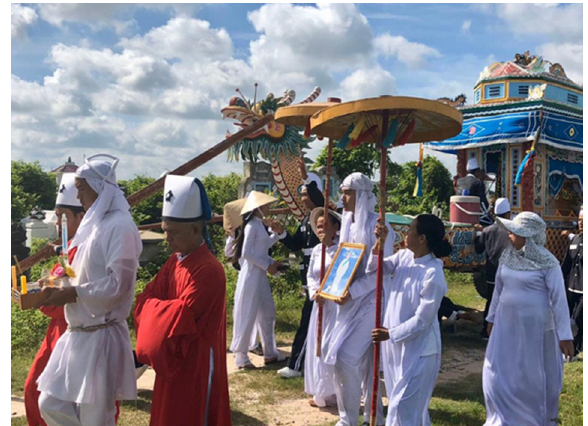
Figure 13. On the way to the cemetery, with the coffin placed in the Bát Nhã boat, behind the procession, Tây Ninh, 2 July 2018 (© Shao Zhu Shuai).